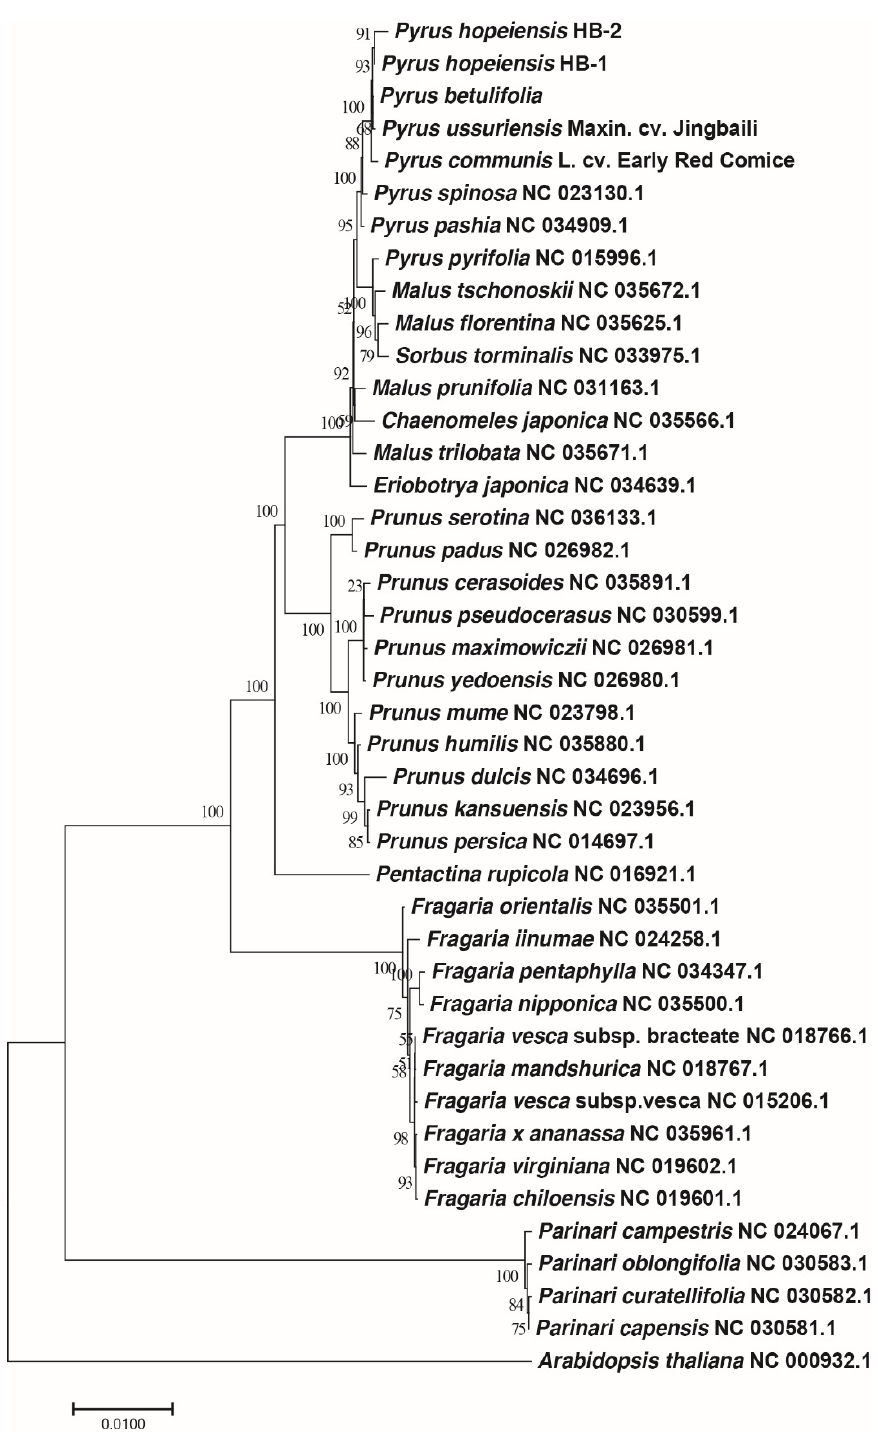
Figure 7. The ML phylogenetic tree of the Rosaceae clade based on same protein-coding genes. Numbers above or below the nodes are bootstrap support values.